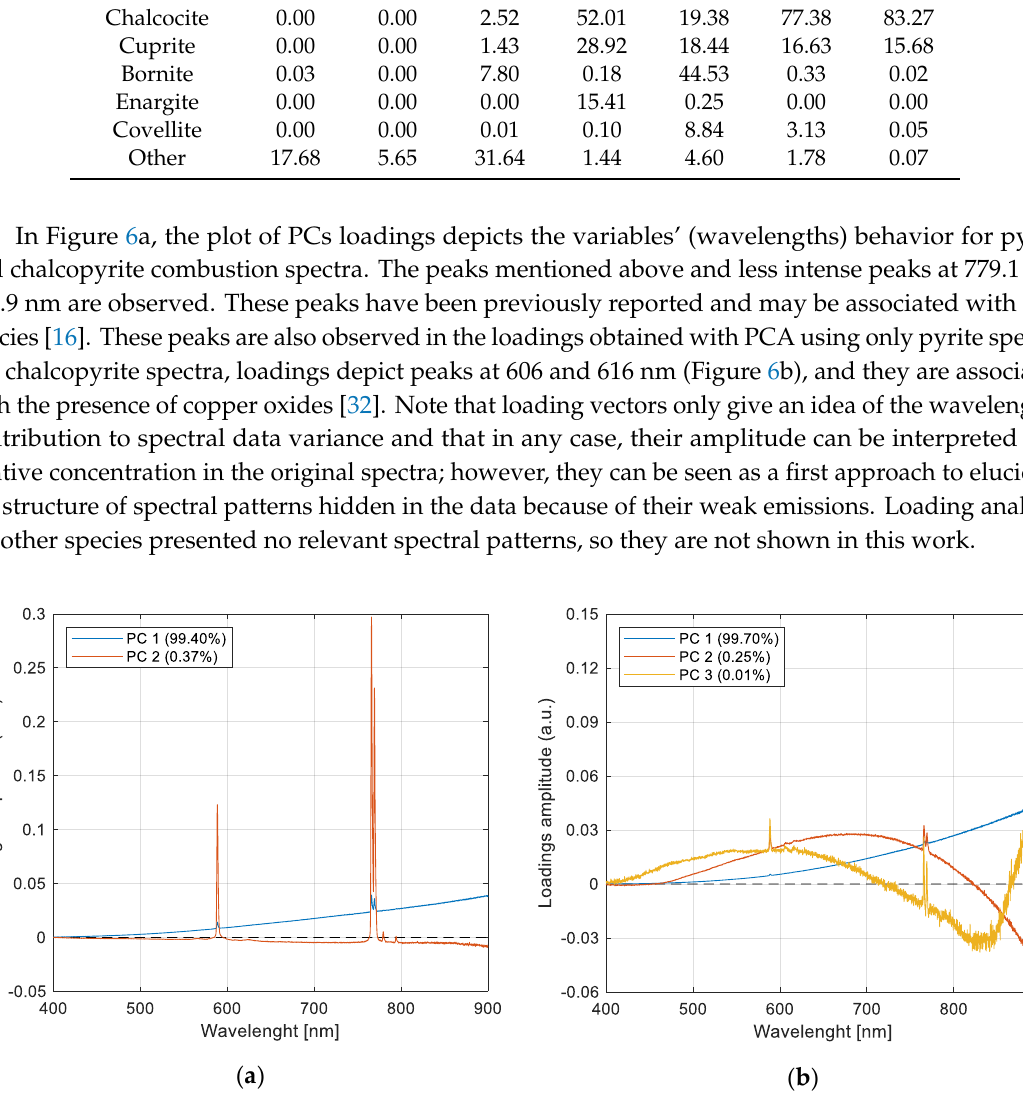
Figure 6. ( a ) PC1,PC2 loadings plots of pyrite combustion and ( b ) PC1 – PC3 loadings plots of chalcopyrite combustion.